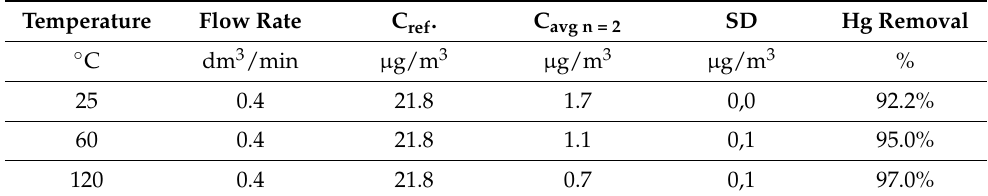
Table 4. FSM testing at three different temperatures of 25 ◦ C, 60 ◦ C, and 120 ◦